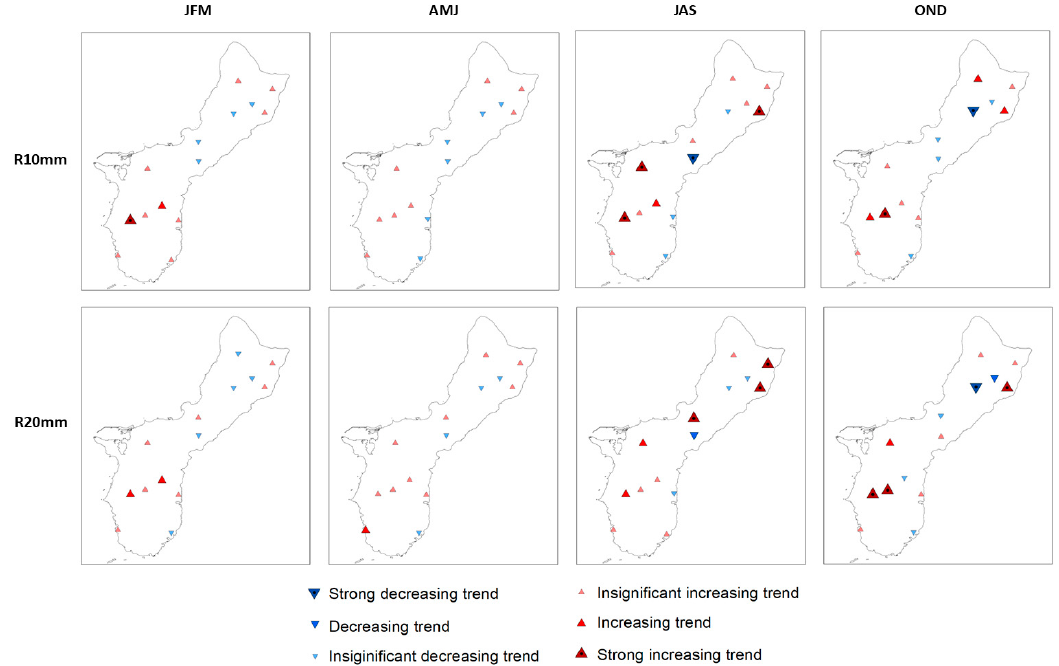
Figure 6. Spatial distributions of seasonal trends of the extreme rainfall indices: the number of heavy-rain days exceeding 10 mm/day (R10mm, days) and the number of heavy-rain days exceeding 20 mm/day (R20mm, days). Columns represent each season, and rows represent each index.